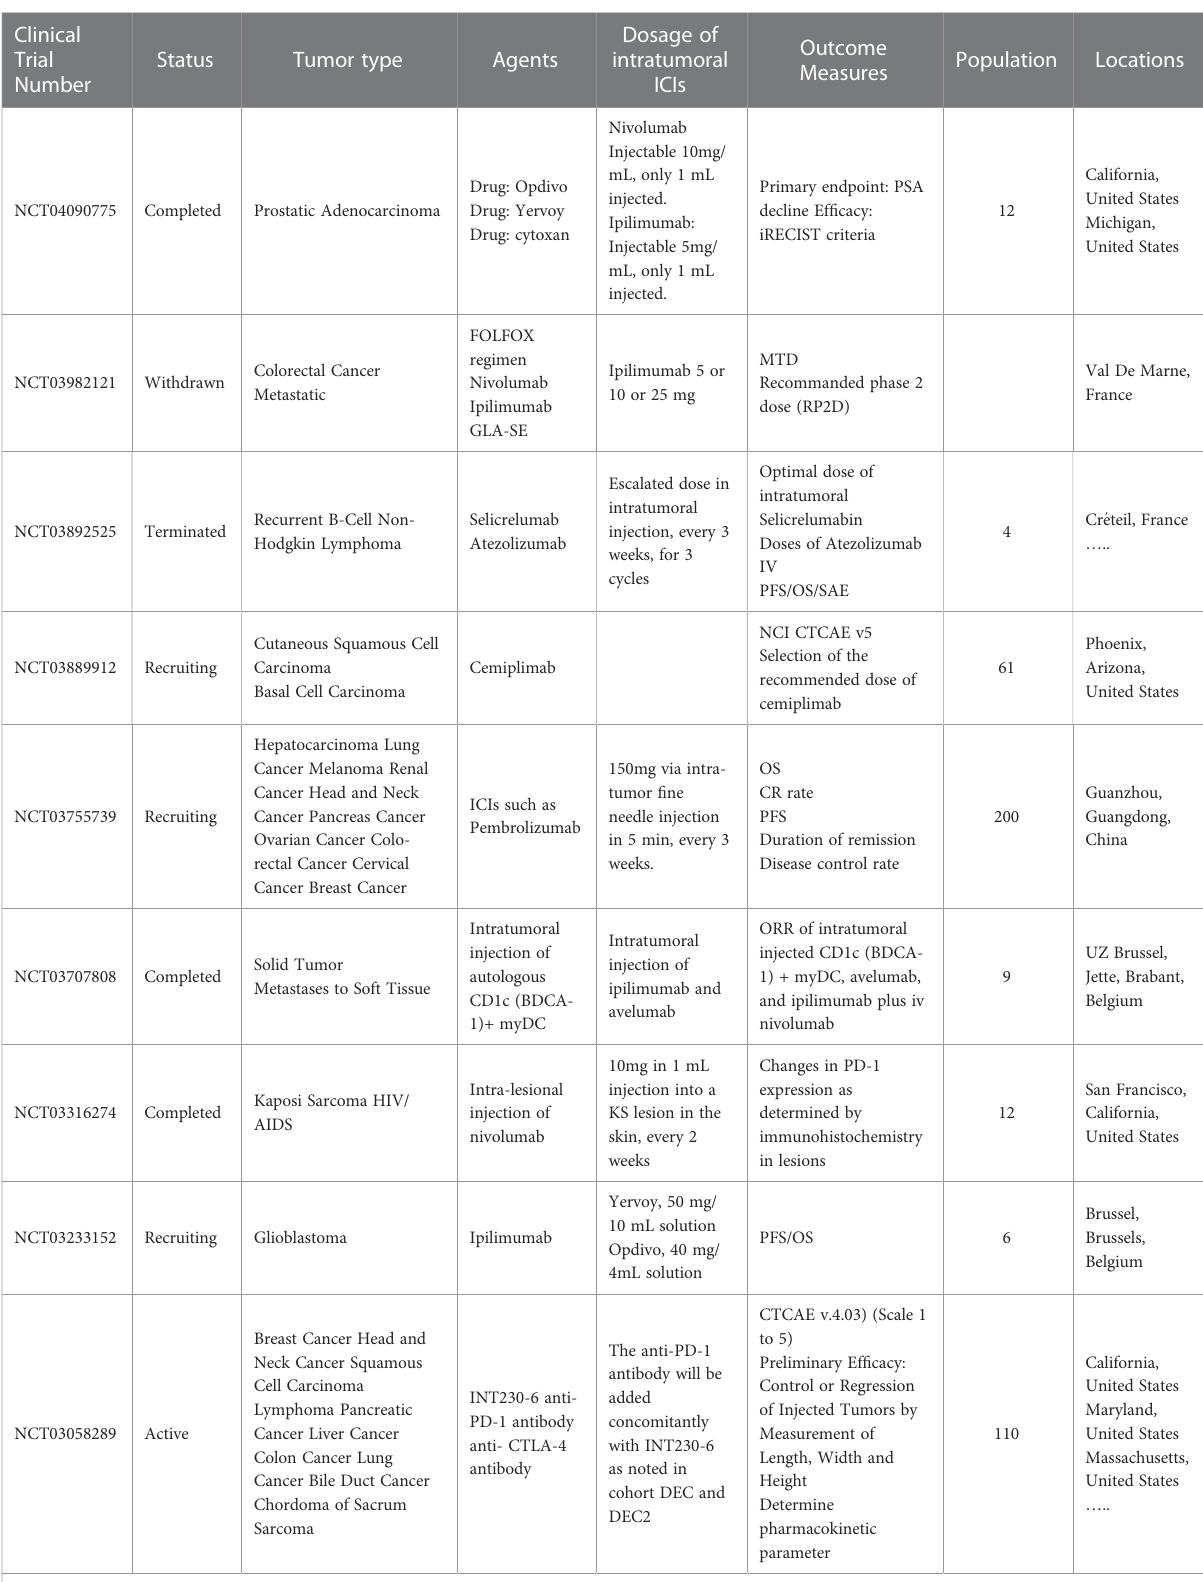
TABLE 2 Registered clinical trial of intratumoral injection of immune checkpoint inhibitors (ICIs).